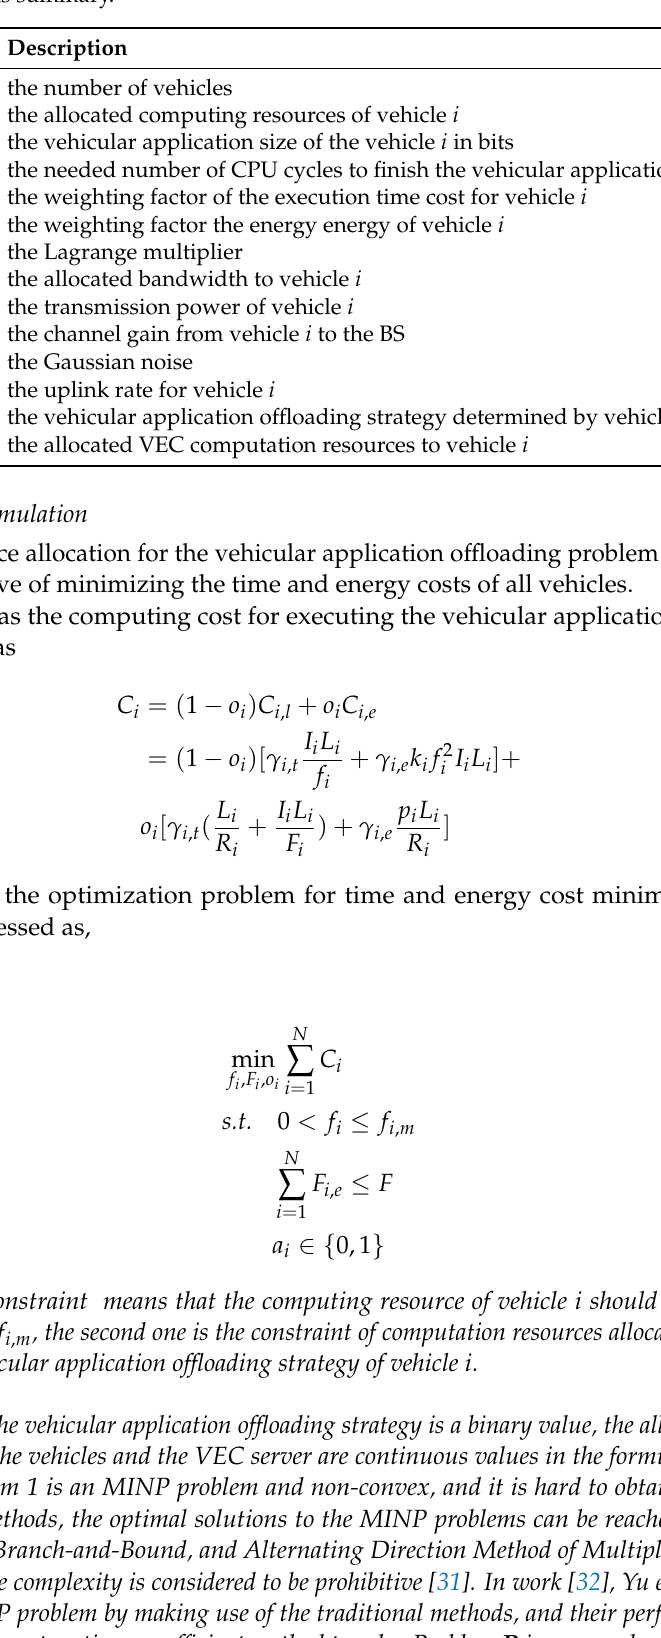
Table 1. Notations